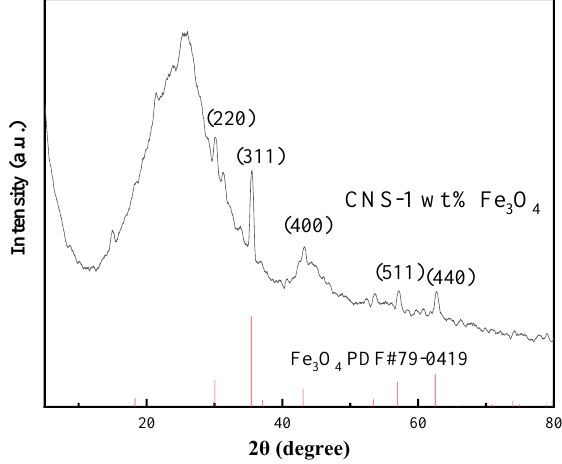
Figure 3. XRD patterns of the scratched powder after laser ablation. The microstructures of the as-prepared Fe 3 O 4 /CNS nanocomposite films were investigated by scanning electron microscopy (SEM) and transmission electron microscopy (TEM). Figure 4a,b is the top view of a scanning electron microscope image. Unlike pristine smooth Fe 3 O 4 /PI film, a 3D porous morphology was formed on the topmost layer of the composite film after the laser ablation, which might have been caused by the release of discomposed volatile gas during the laser ablation. The periodic folded nanoflakes with a thickness of less than 100 nm are more easily seen, as depicted in Figure S1. According to the cross-sectional scanning electron microscope image of the abated composite film in Figure 4c, the total thickness of the carbonized layer is about 37.5 μm. The high magnification image in Figure 4d shows that these carbon nanosheets directly grow on the substrate and can be integrated into a self-supporting film. More importantly, this unique alignment of carbon nanosheets could be beneficial for alleviating the aggregation of gas bubbles and facilitating the detachment of H 2 from electrodes in water electrolysis. Finally, it should be noted that the backside of the ablated film was believed to be gently carbonized due to the visible color variation [17].